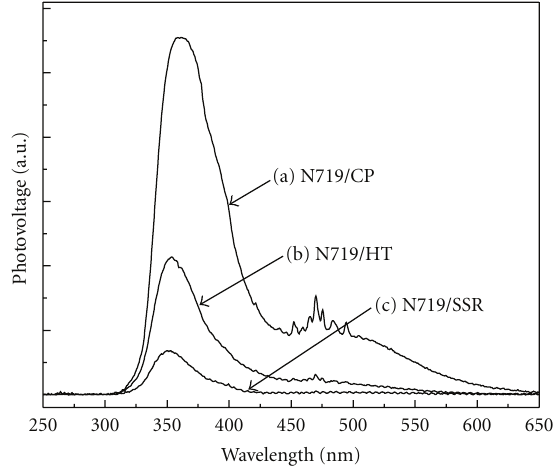
Figure 7: Surface photovoltage spectra of N719/CP (curve a) sample, N719/HT sample (curve b), and N719/SSR sample (curve